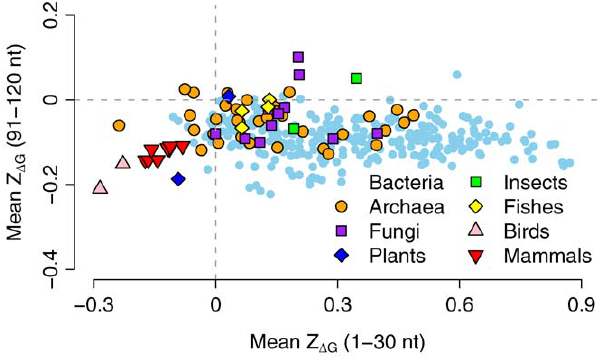
Figure 2. The mean Z D G of the tenth window vs. the mean Z D G of the first window (5 9 Z D G ). Each data point represents the entire genome of one organism.